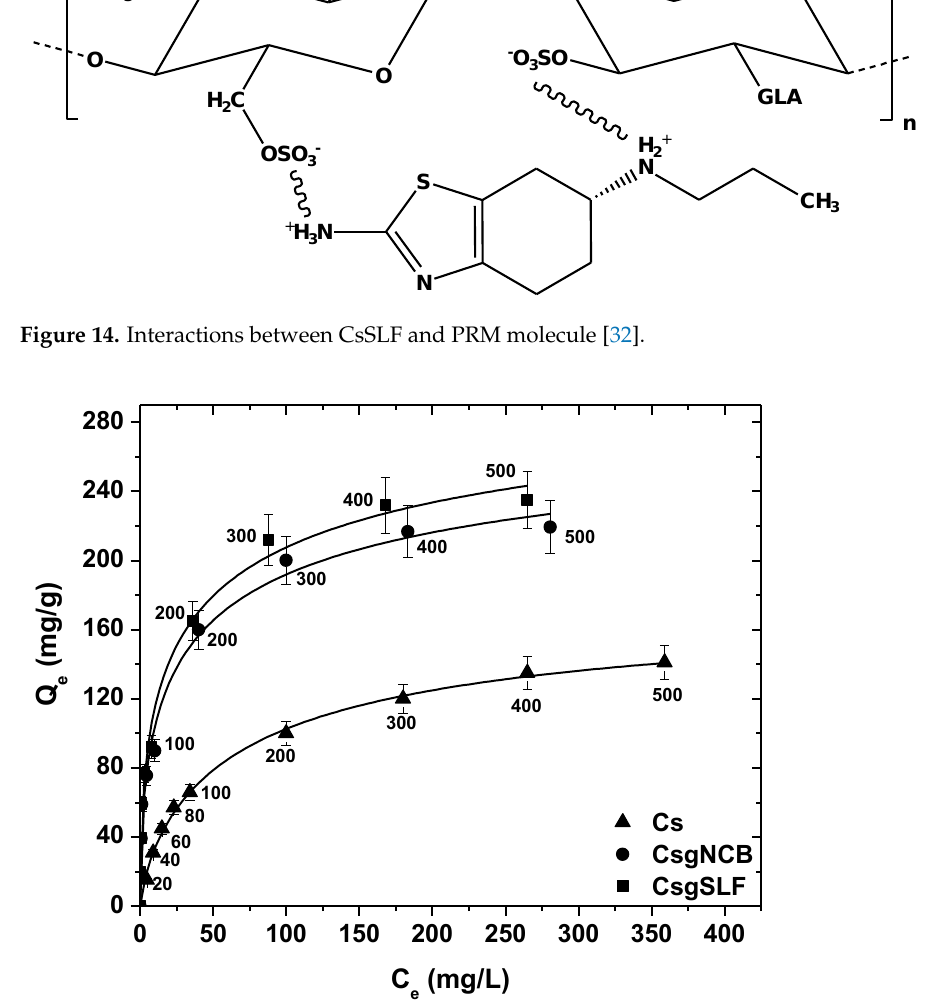
Figure 15. Effect of initial PRM concentration on adsorption onto Cs, CsNCB, and CsSLF at 25 ◦ C [32].